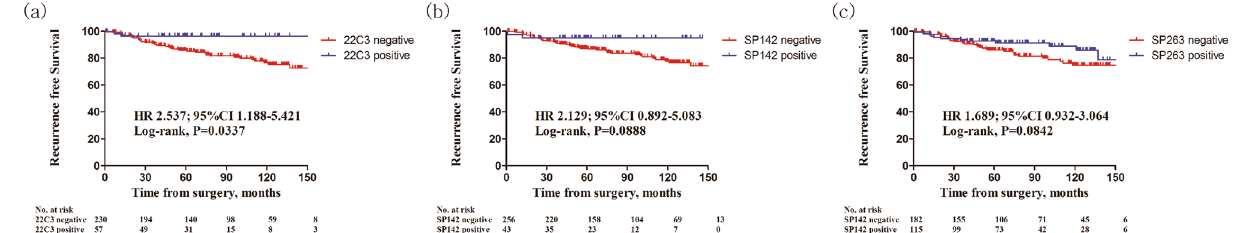
Figure 3. Kaplan–Meier survival curves of recurrence-free survival (RFS) in relation to PD-L1 expression based on PD-L1 antibody-IHC assays in patients with breast cancer. ( a ) Patients with negative PD-L1 expression based on the 22C3-IHC assay were associated with poor RFS (HR 2.537, 95% CI 1.188–5.421, P = 0.0337, log- rank test). ( b , c ) PD-L1 expression with SP142- and SP263-IHC assays did not show significantly different RFS.